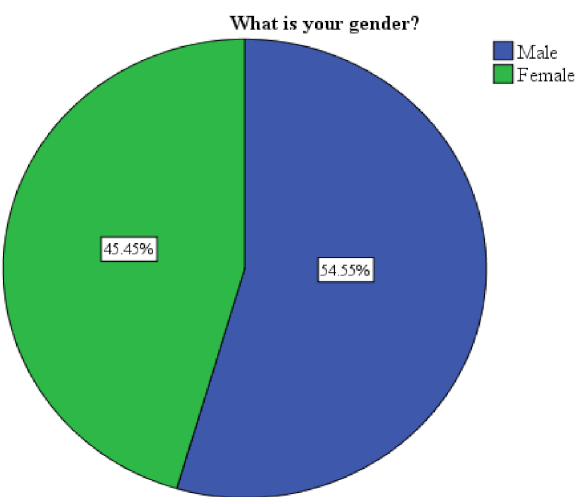
Figure 1. Gender of the respondents.